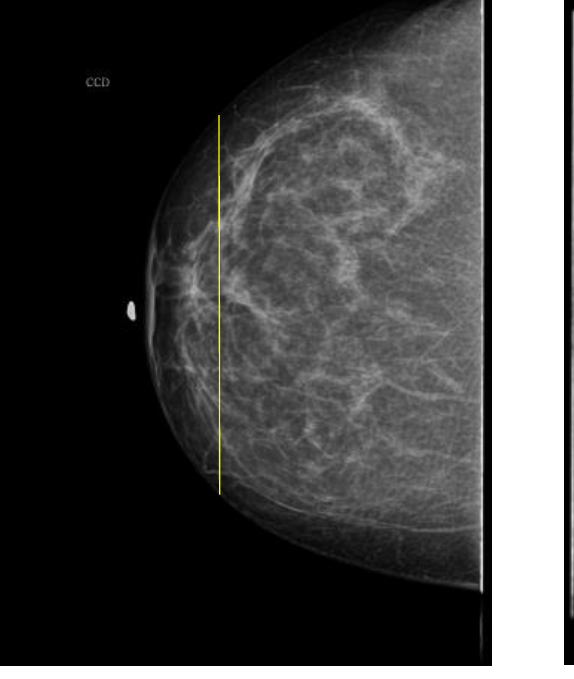
Figure 9. CC mammogram images of participant 4 and relative electrode ring position (yellow ver- tical line): ( a ) right breast; ( b ) left breast.